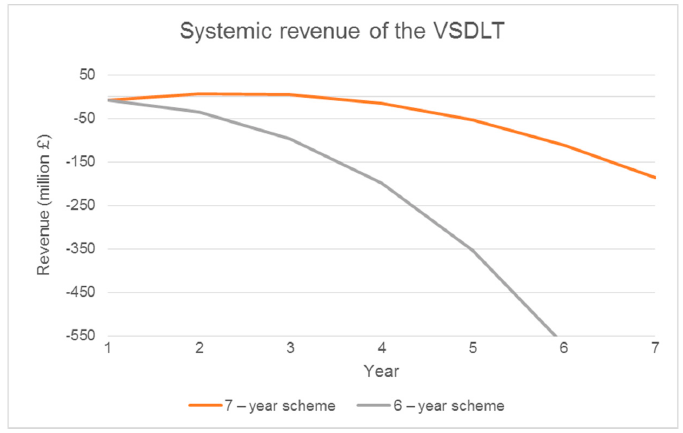
Figure 2. Systemic revenue of the Variable Stamp Duty Land Tax (VSDLT).